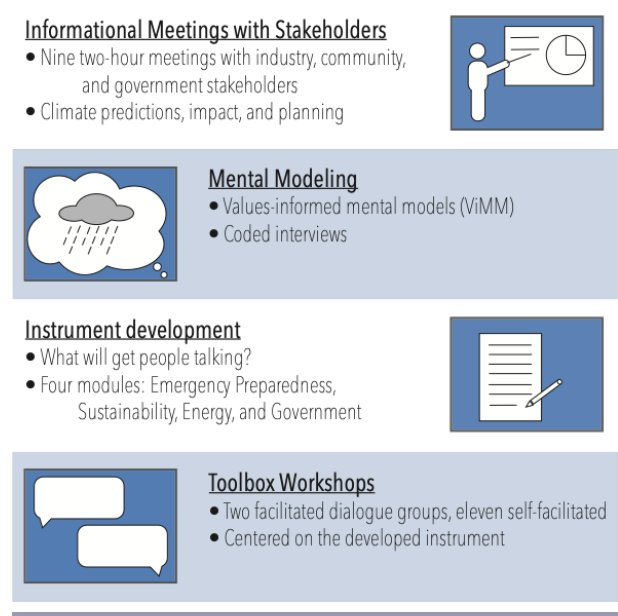
Fig. 1. The four methods used to produce Toolbox workshops for the 2014 West Michigan Climate Resiliency